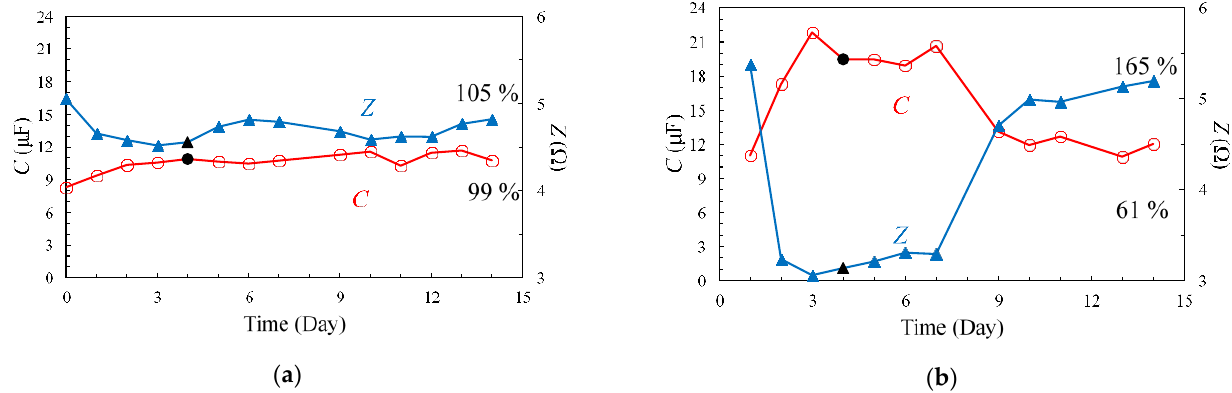
Figure 11. C and Z characteristics at 1 kHz with ( a ) and without ( b ) discharge.